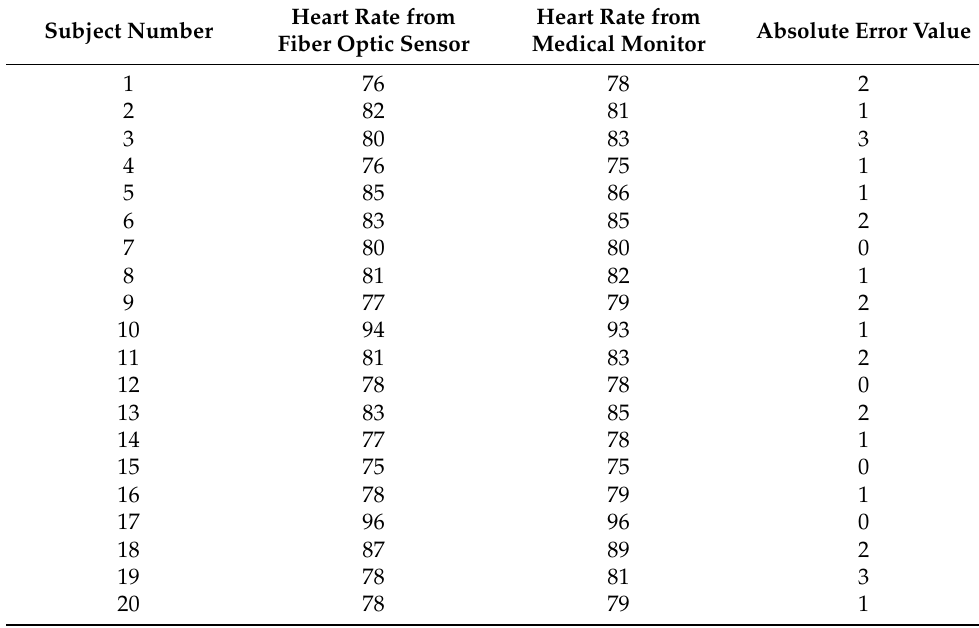
Table 2. Results of heart rate compared between fiber optic sensor and medical ECG